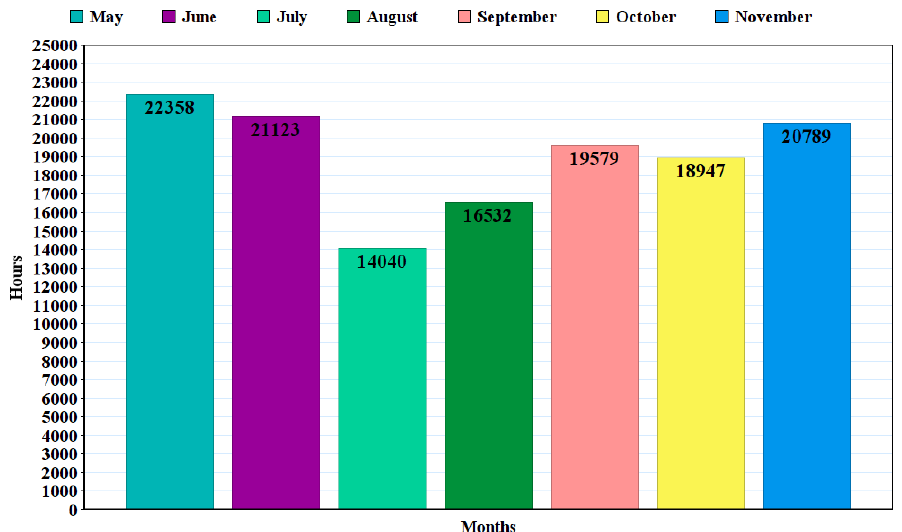
Figure 14. Distribution of the recoded total parking hours per month.